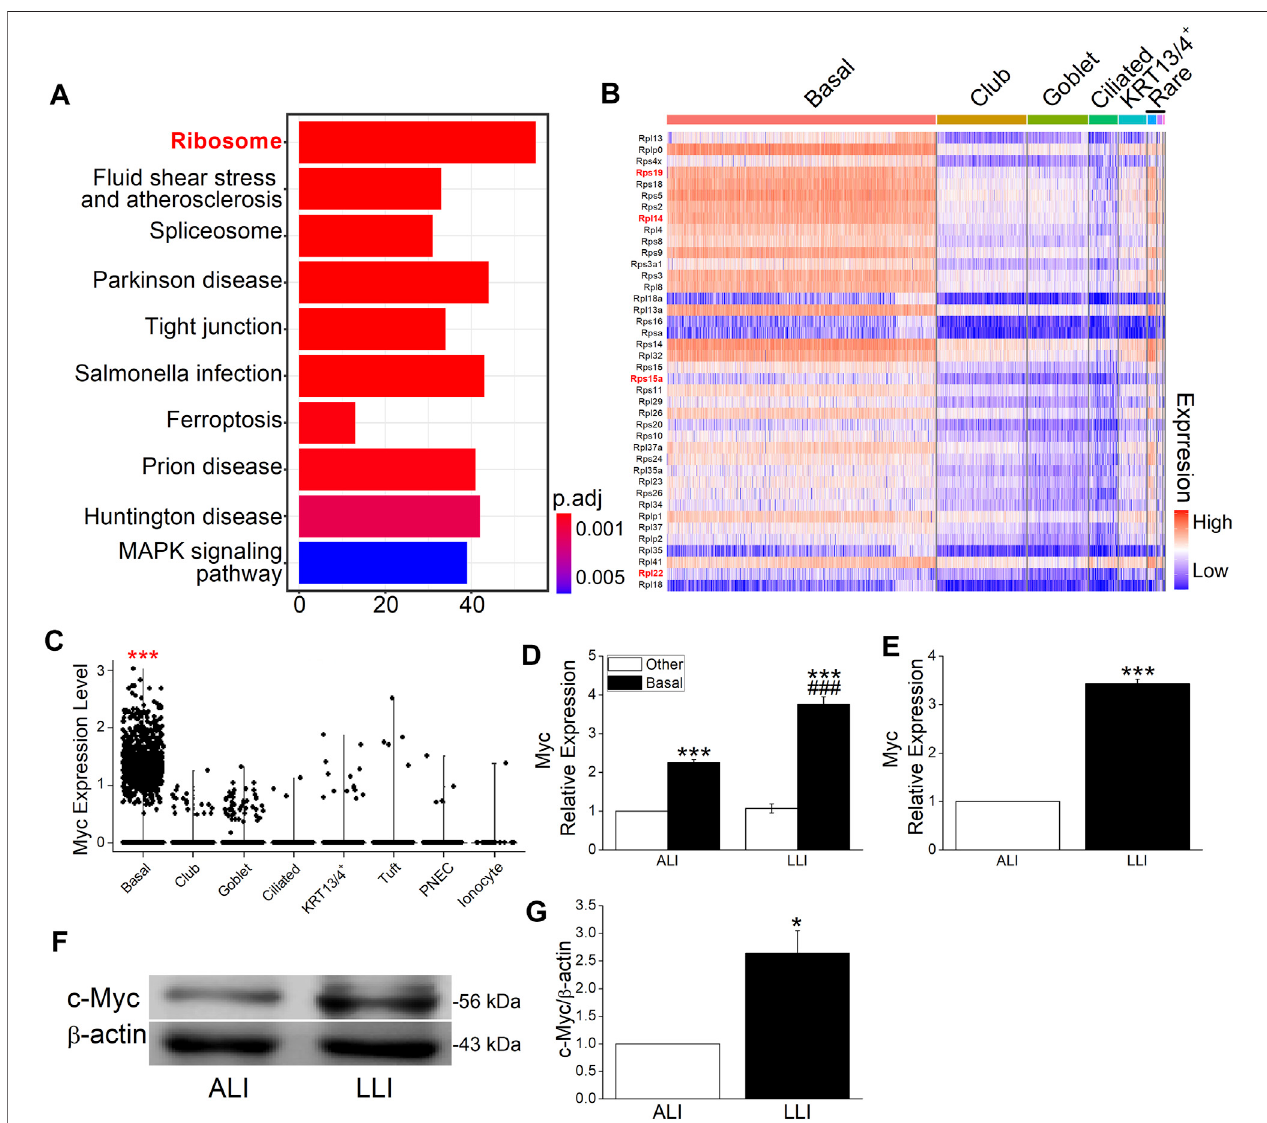
FIGURE4| Mycandribosomeproteinswereenrichedinbasalcells. (A) Top10enrichedpathwaysofspeci fi callyexpressedgenesinbasalcells.Numbersin x -axis represent the genes enriched in the corresponding pathway. P adjust ( p . adj) varies from .01 to 0.05. (B) Top 40 ribosome proteins among different cell types. The red and bold fontmarked genes wereclosely associatedwithEMT. (C) Myc in differentairway epithelial cells. *** p . adj < .001. (D) Heterogeneously expressed Myc mRNA in differentairwayepithelialcelltypes afterLLIculture. *** p < .001compared withtheothercellsincorresponding group. ### p < .001,compared withALIgroupwithin thesamecelltype. n (cid:1) 3.One-wayANOVAfollowedbyBonferroni ’ stestwasusedtoanalyzethedifferenceofthemeansforsigni fi cance. (E) ExpressionofMycmRNAin ALI and LLI group. *** p < .001, compared with ALI group, n (cid:1) 3. Student ’ s t -test was used to analyze the difference of the means. (F – G) Representative and statistical data of c-Myc. ** p < .01, compared with ALI group, n (cid:1) 4. Mann – Whitney U test was used to analyze the difference of the means for signi fi cance.